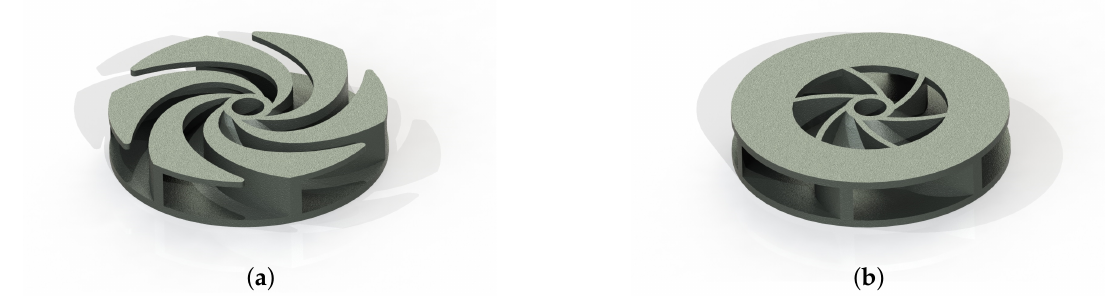
Figure 6. Schematic view of impellers ( a ) with winglets; and ( b ) with front